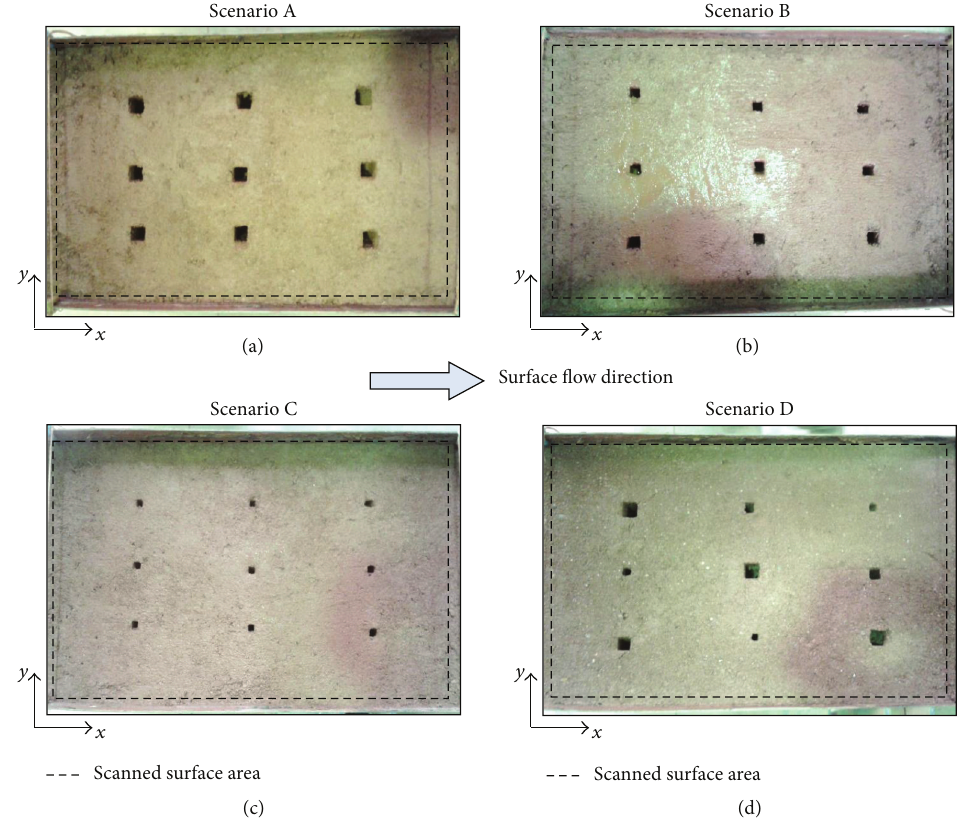
Figure 2: Top view (photographs) of the flume soil surface showing macropores of different sizes scattered in accordance with the four scenarios described in the text: (a) Scenario A; (b) Scenario B; (c) Scenario C; and (d) Scenario D. The 𝑥 -axis represents the downslope distance along the length of the flume and the 𝑦 -axis represents the distance across the width of the flume (the dashed line defines the measuring area with 0.50 × 0.30 m 2 ). See Figure